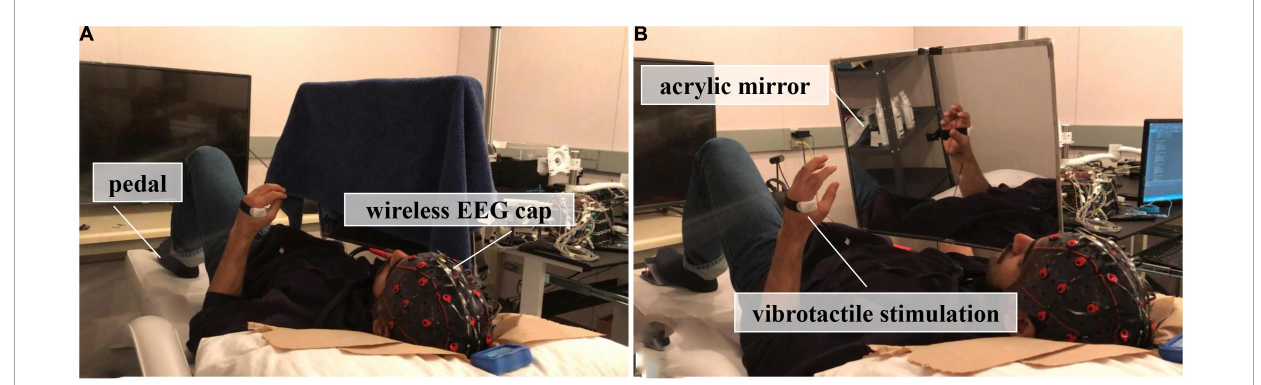
Figure 1A . In the subsequent session, subjects conducted the same hand motor task with MVF while vibrotactile stimulations were applied randomly, see Figure 1B . The vibrotactile stimulation